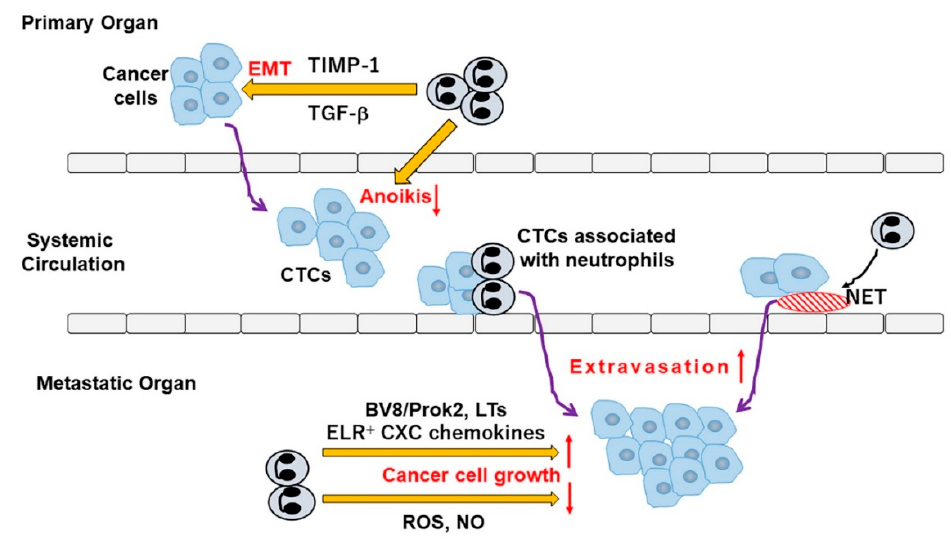
Figure 4. Presumed roles of TANs in metastasis processes.